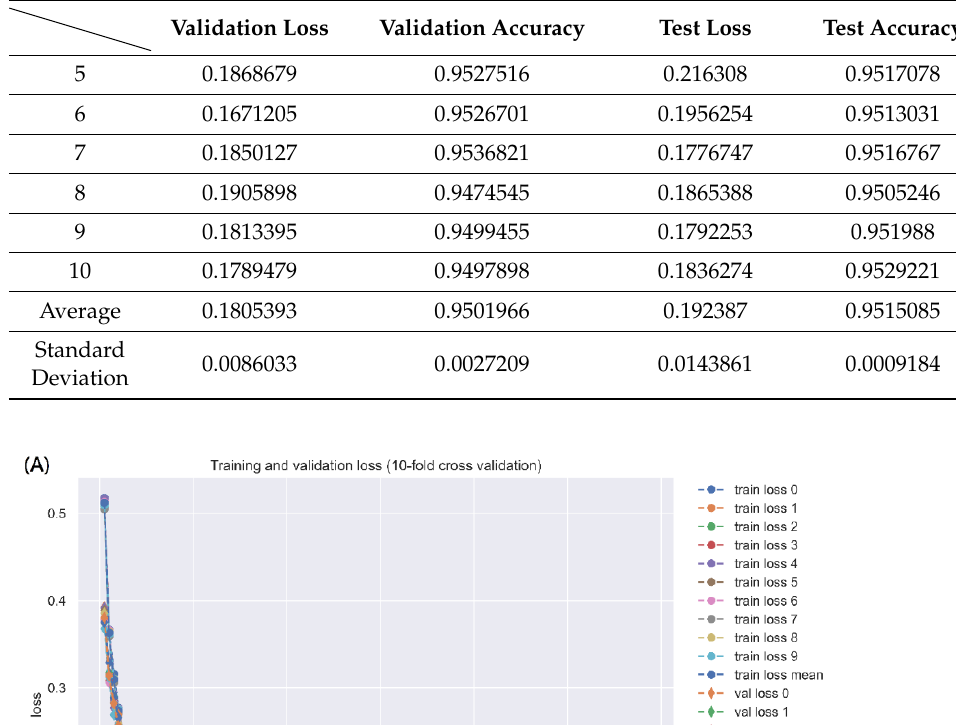
Table 4. The prediction performance of DNN-based DTI model by 10-fold cross-validation. Table 4. Cont.